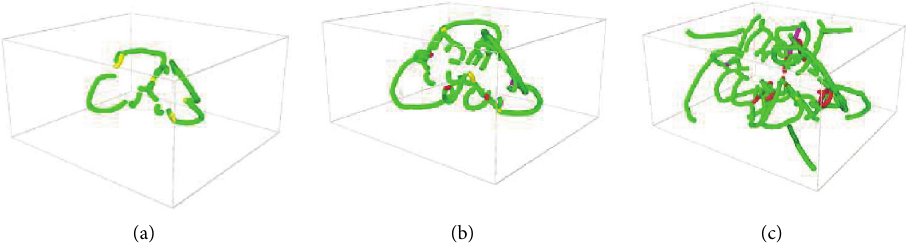
Figure 8: The dislocation lines for the compressive strain from the void surface (-7%–8%). (a) ε